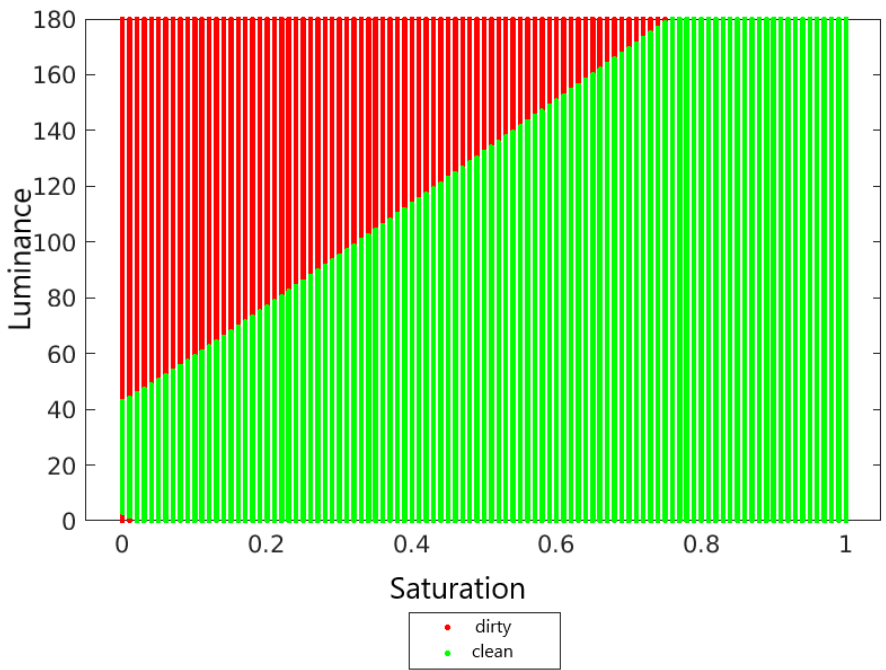
Figure 9. Decision surface for the naive Bayesian